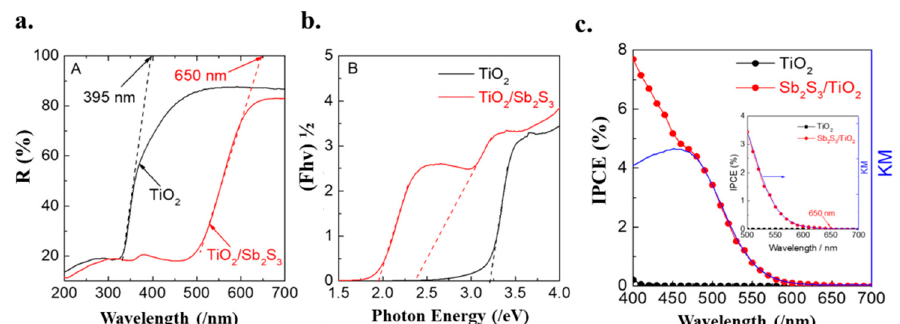
Figure 5. ( a ) Diffuse reflection spectrum of TiO 2 (black) and Sb 2 S 3 /TiO 2 (Red); ( b ) Tauc plots of TiO 2 (black) and Sb 2 S 3 /TiO 2 (red). The dashed lines show tangent lines near the edges of the plots, respectively, ( c ) Action spectra of IPCE of theTiO 2 (black) and Sb 2 S 3 /TiO 2 (red) electrode in a 0.1 M phosphate buffer solution of pH 6.0 at − 0.3 V vs. Ag/AgCl. The insets show the magnified spectra near the edges.